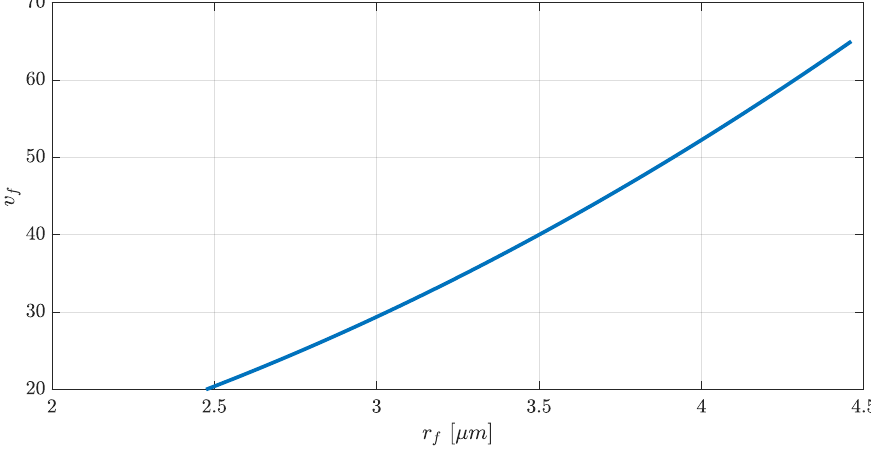
Figure 6. Relation between the volume fraction, v f , and the fiber radius, r f